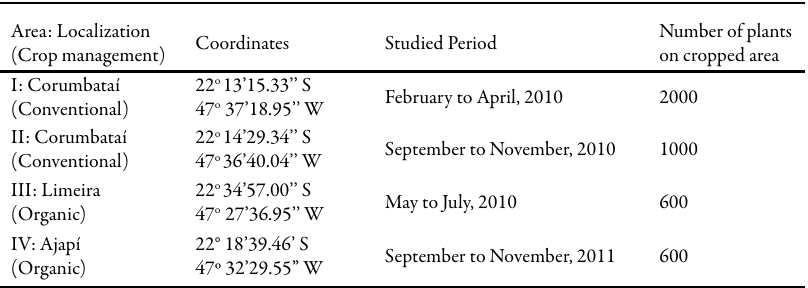
Table 1. Crop management, localization, number of specimens cultivated and period of study in the four studied